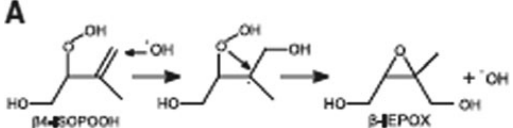
Fig. 9. Reaction mechanism for the formation of an epoxide and the regeneration of OH [58].